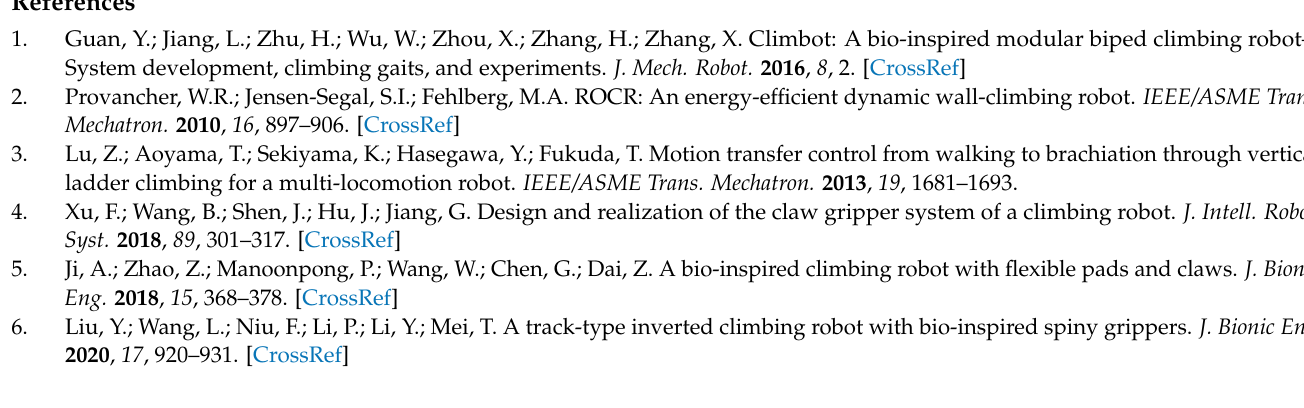
Figure 26. Snapshots showing ledge brachiation experiment (Exp. (h): gap distance: 192 mm, elevation: 56 mm).